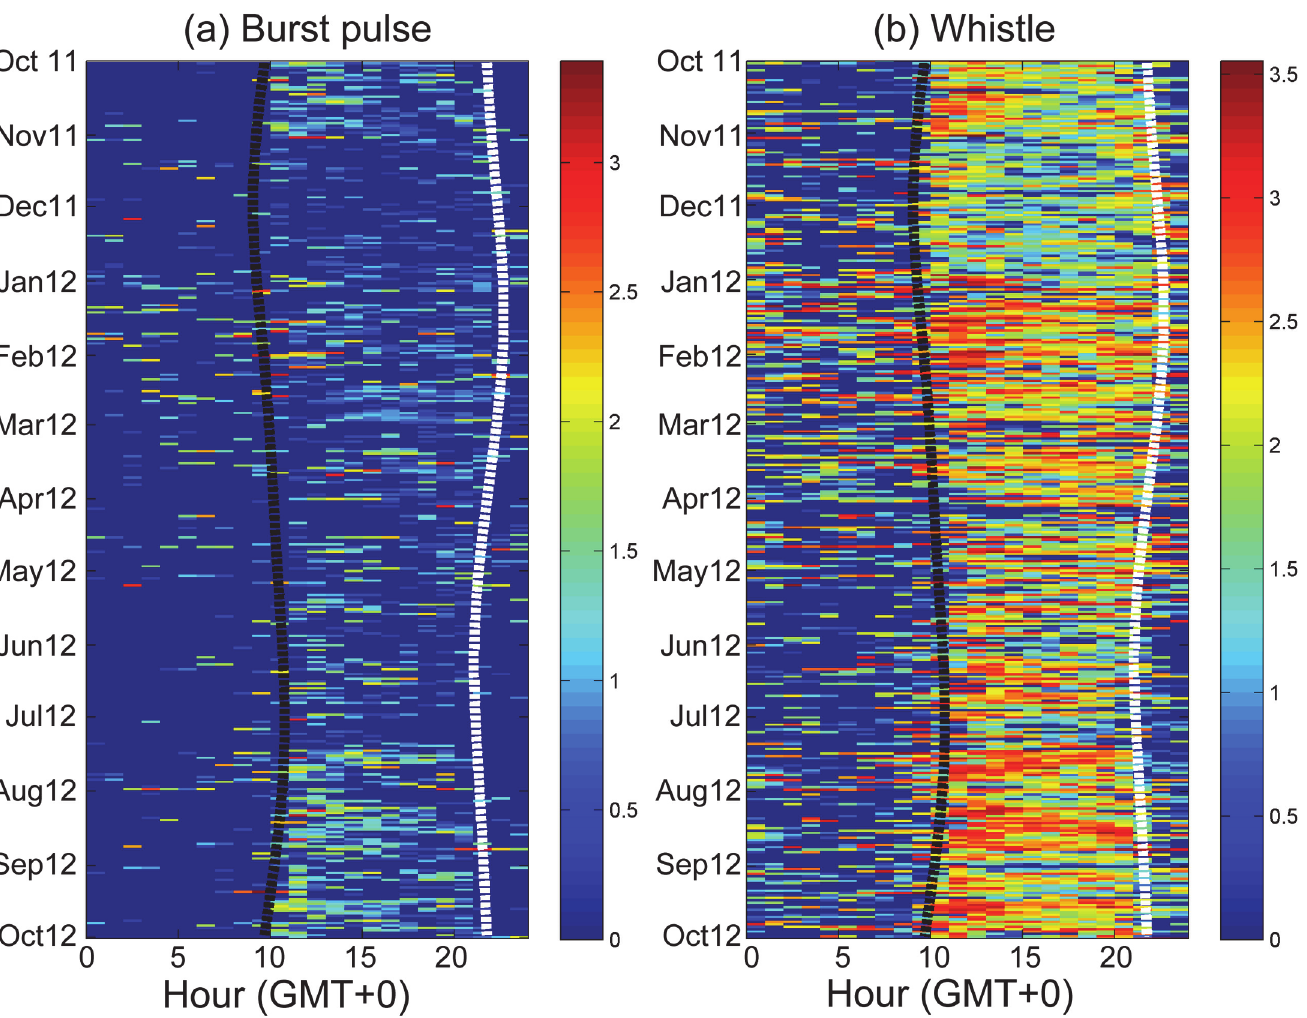
Fig 3. Seasonal and diurnal variation of detected durations in burst pulses (a) and whistles (b). The number of detected seconds was calculated hourly and is presented in log scale (colorbar). The black dashed line represents the time of sunset, and the white dashed line represents the time of